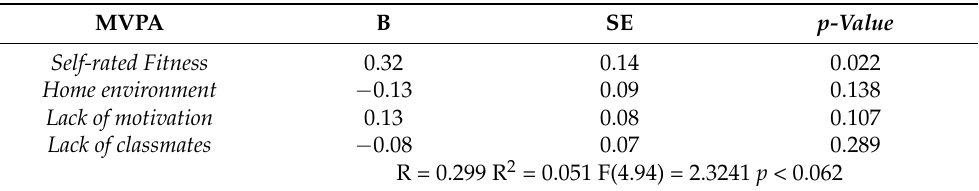
Table 2. Summary of dependent variable MVPA in adolescents, identified on hierarchical regression analysis.